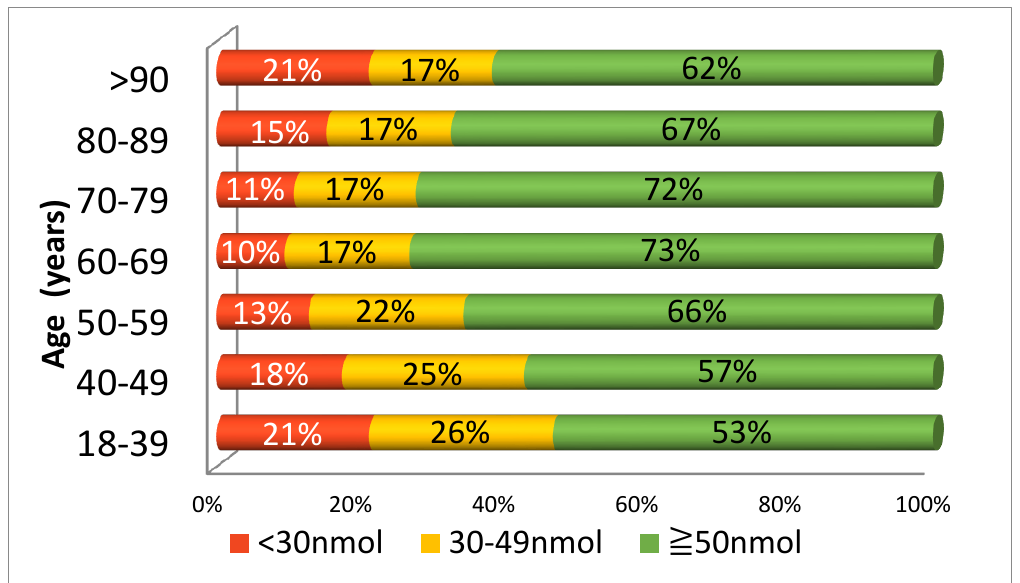
Figure 2. 25(OH)D status in different age categories.